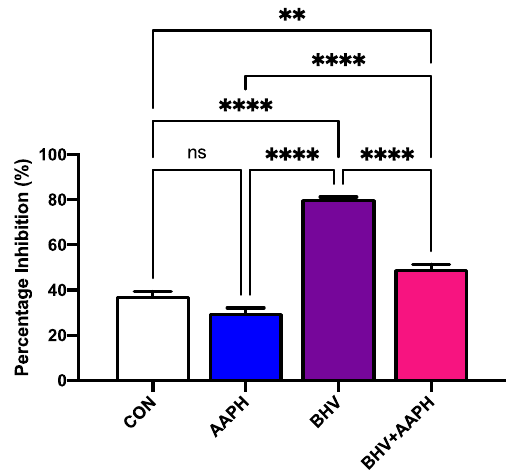
Figure 7. Antigen-specific antibody production across in vitro treatments expressed as estimated means ± SEM of inhibition percentage. CON = Untreated peripheral mononuclear blood cells (PBMCs); AAPH = PBMCs treated with 3 mM of 2,2 ′ -Azobis(2-amidinopropane) dihydrochloride (AAPH); BHV = PBMCs treated 8 × 10 4 TCID 50 Bovine Herpesvirus 1 per 1 × 10 6 PBMCs; BHV-1 + AAPH = PBMCs treated 8 × 10 4 TCID 50 Bovine Herpesvirus 1 per 1 × 10 6 PBMCs